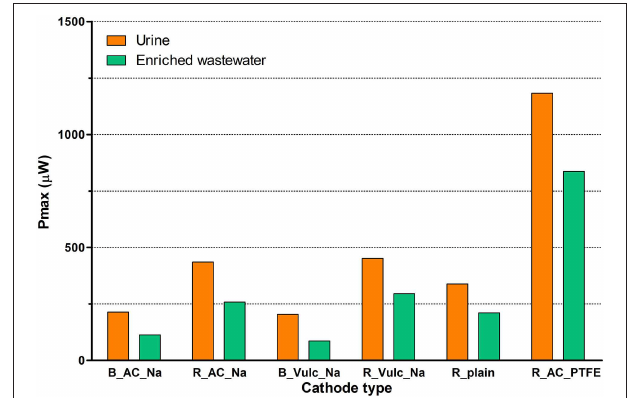
FIGURE 4 | Maximum power outputs of different feedstock tested in Type 1 brick MFCs. P MAX was calculated from power curves. All anodes and cathodes in a single brick connected in parallel.